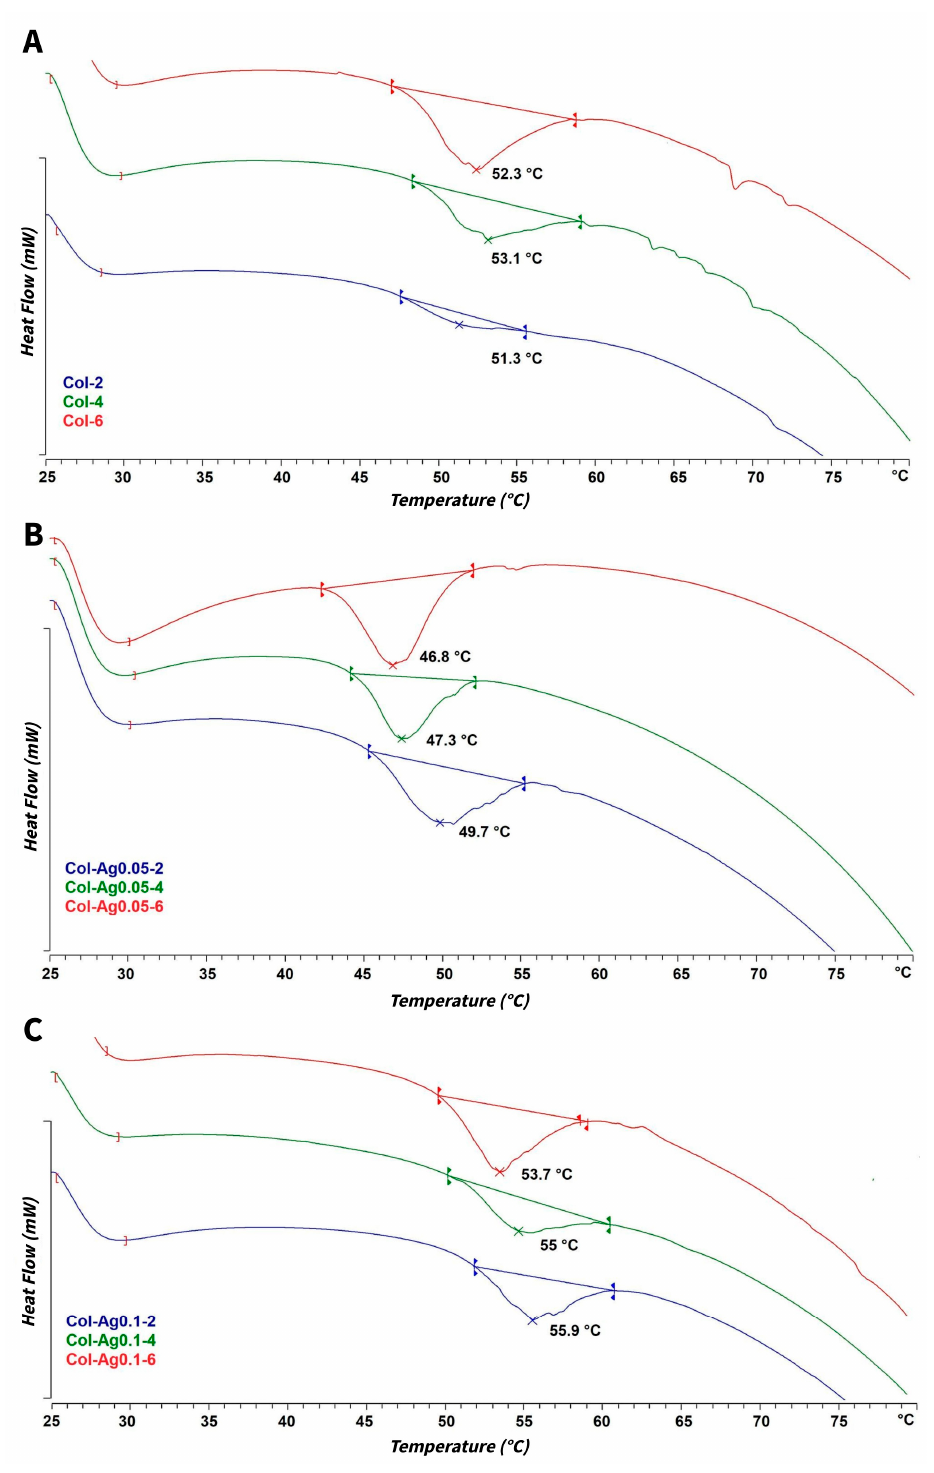
Figure 6. DSC thermal analyses for 3D-printed Col ( A ), Col-Ag0.05 ( B ), and Col-Ag0.1 ( C ) scaffolds after different UV irradiation times.